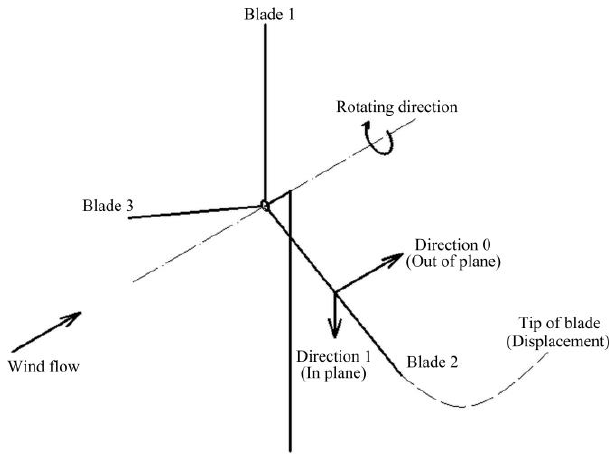
Figure 2. Coordinate system of the blade deflection.